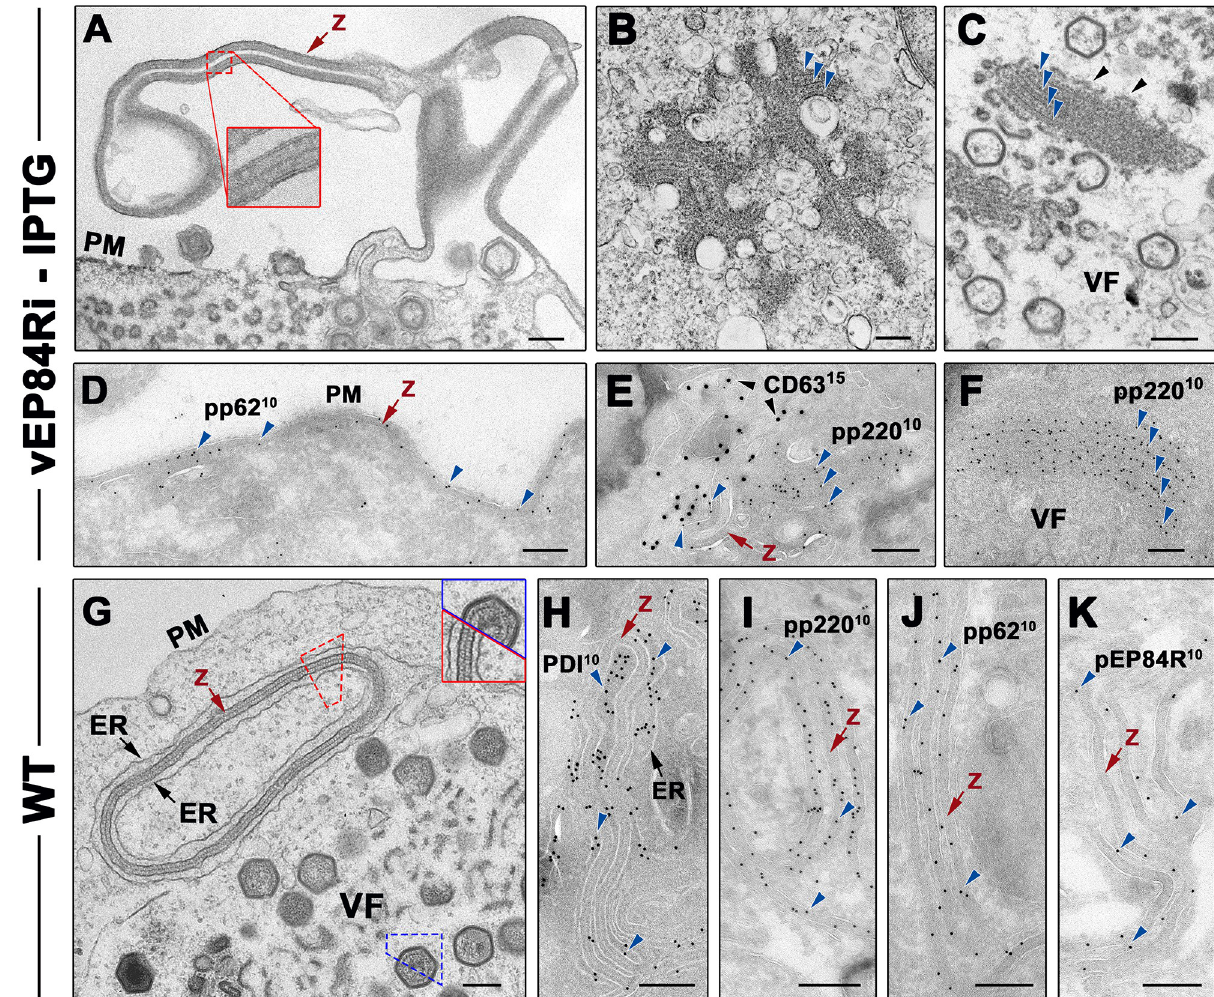
Fig 4. The absence of pEP84R leads to the accumulation of mistargeted core shell-like assemblies of pp220 and pp62 polyproteins. Conventional EM analysis (A-C and G) and immuno-EM (D-F and H-K) of cells infected with vEP84Ri in the absence of IPTG (A-F) or with wild type (WT) virus (G-K). In the absence of pEP84R, core shell-like assemblies of unprocessed pp220 and pp62 precursors, termed zippers (z), attach to the cytosolic face of the PM (A) and endosomal-lysosomal membranes (B). The inset in A shows a detail of a zipper associated to the PM. (C) Within the viral factories (VF), parallel stacks of core shell-like assemblies (blue arrows) displaying loose contacts to viral membranes (black arrowheads) are detected. Immunogold labeling of zippers with antibodies to pp62 (D) and pp220 (F) followed by protein A-gold (10 nm). (E) Double labeling of endosome- associated zippers with anti-pp220 and anti-CD63 antibodies followed by 10 and 15-nm gold conjugates, respectively. (G) ER-associated zipper (z) in close proximity to a wild type virus factory. The top right inset shows the similarity between the core shell of an assembling particle (blue outline) and a zipper structure (red outline). (H-K) Immuno-EM of ER-associated zippers with antibodies to luminal ER marker PDI (H), pp220 (I), pp62 (J) and pEP84R (K). Bars, 200